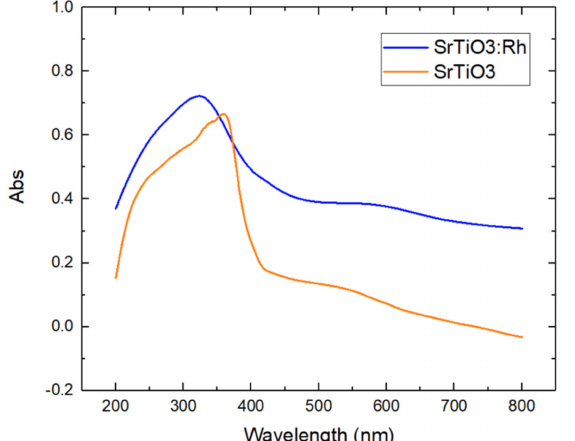
Figure 8. UV–Vis spectrum of strontium titanate (calcination temperature: 1200 ◦ C, pH = 1.5) and rhodium-doped strontium titanate (calcination temperature: 1200 ◦ C, pH =